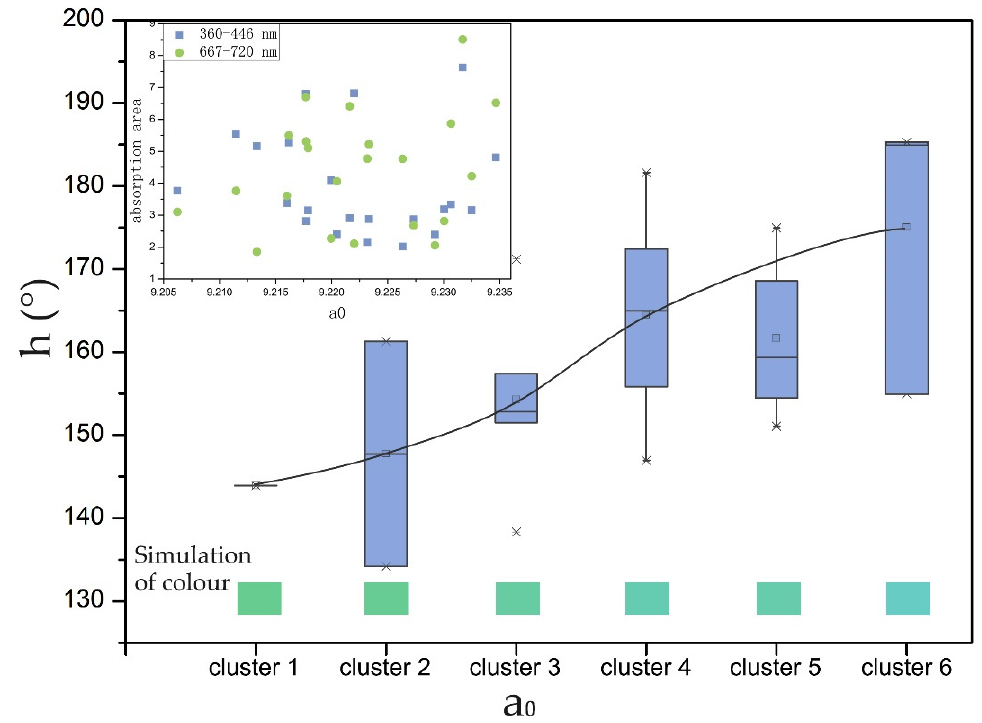
Figure 12. Box diagram of the relationship between a 0 and h; every blue box represents parameters h in the different groups divided by K-means clustering.